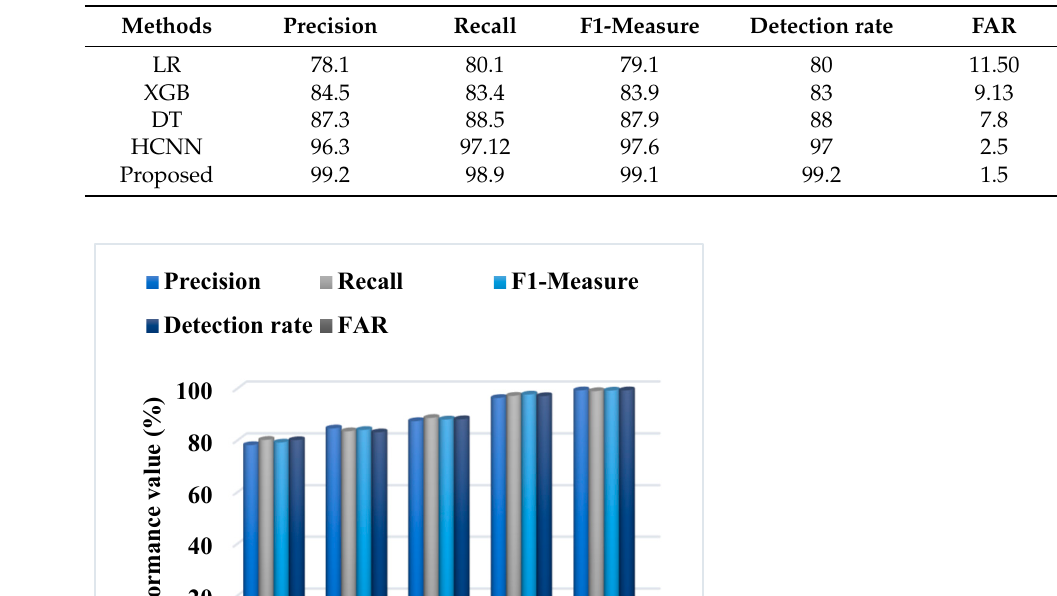
Table 3. Comparative analysis using dataset 3.